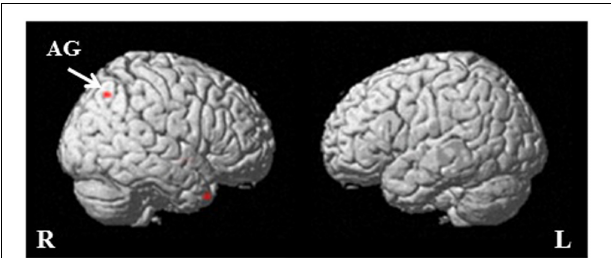
FIGURE 1 | Neural differences between forgiving and not forgiving as measured by fMRI. The red shows where increased activity was observed when participants forgave in comparison to when they did not (taken from Strang et al., 2014). AG, angular gyrus; R, right; L,